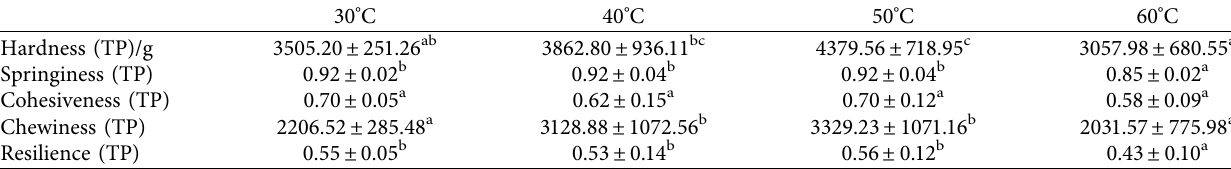
Table 4: Influence of drying temperatures on the texture properties of dried sea cucumber.